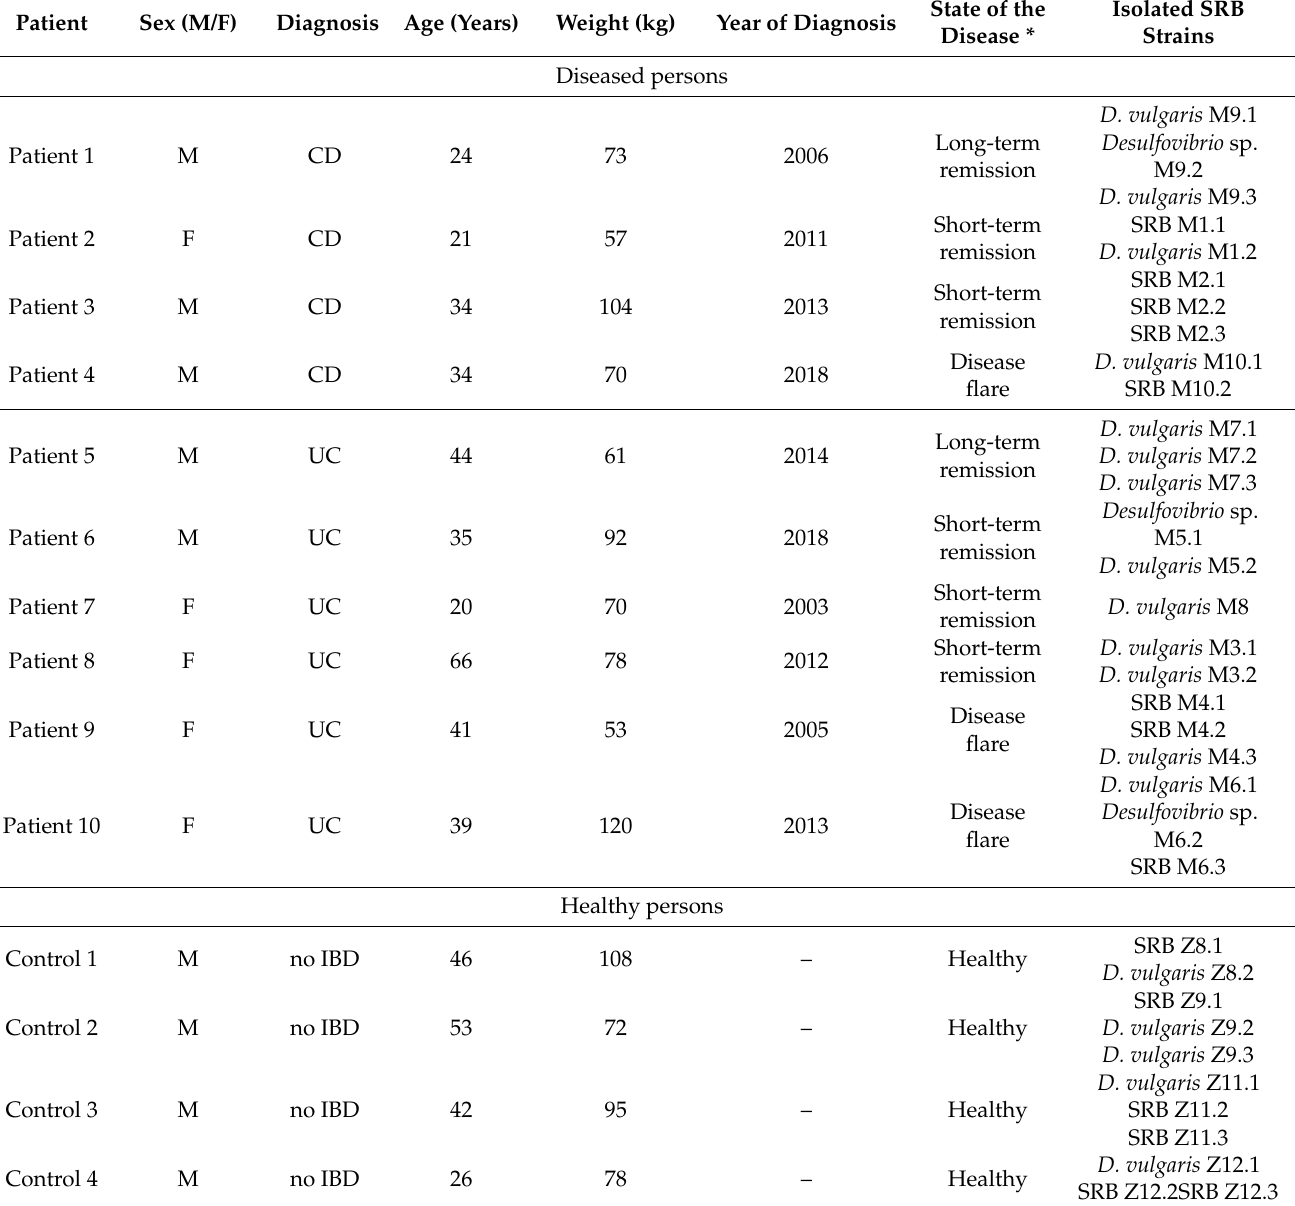
Table 1. Patients and control subject’s characteristics. IBD: inflammatory bowel